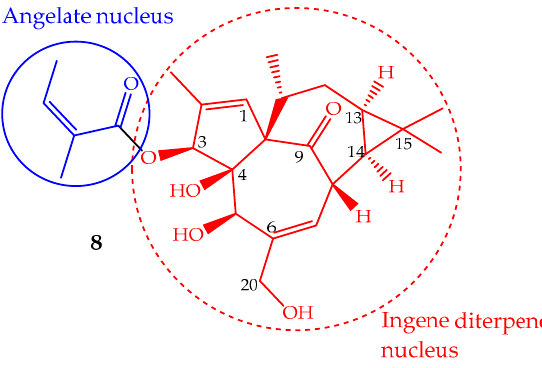
Figure 5. Chemical structure of the diterpene ingenol mebutate ( 8 ).